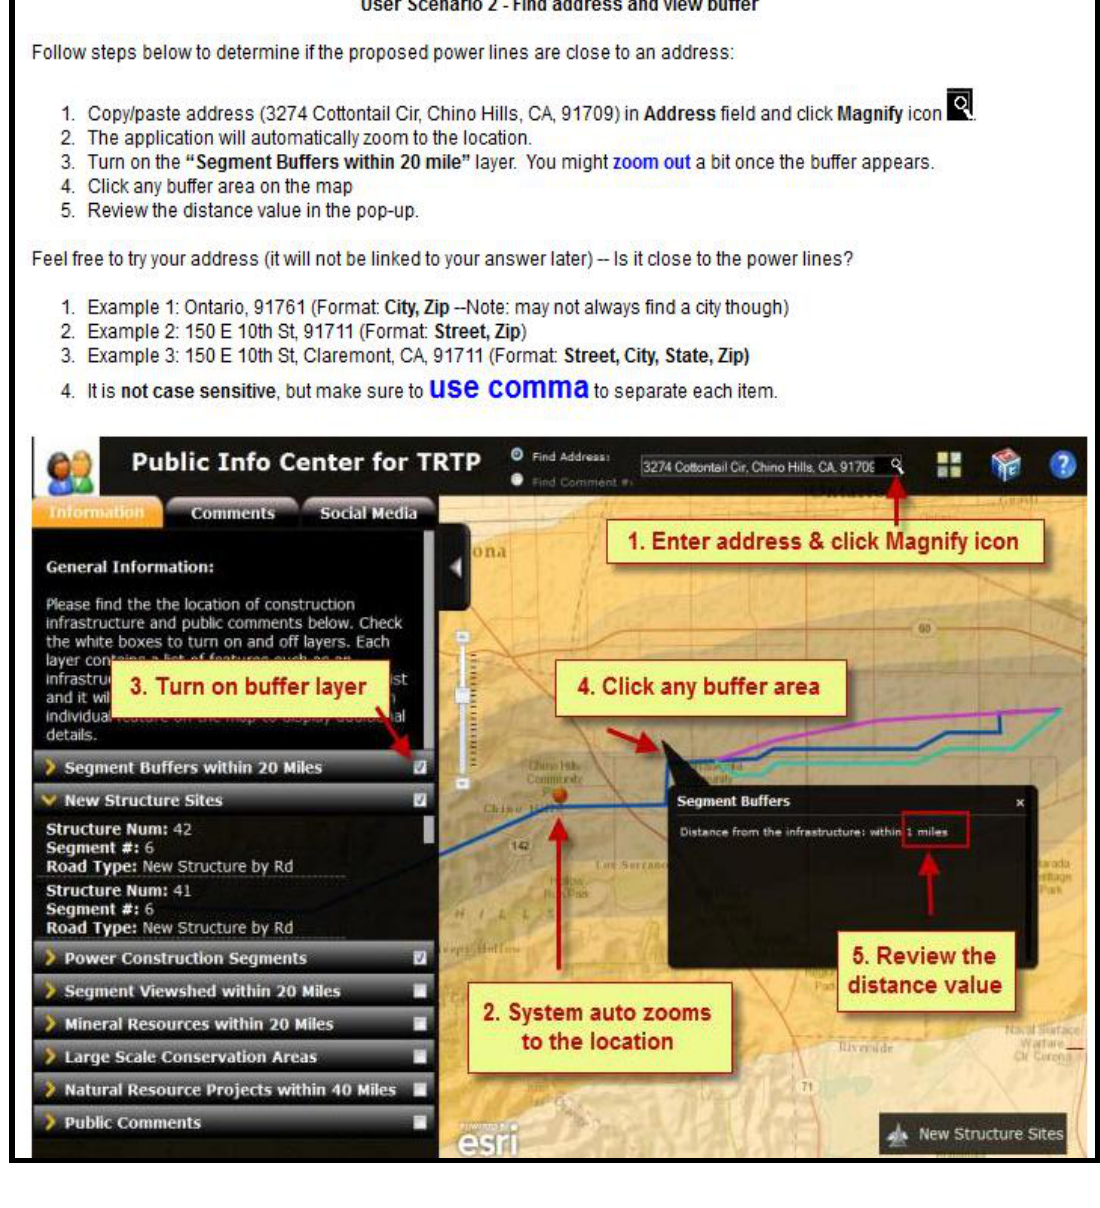
Figure 3. An example of a user scenario in the